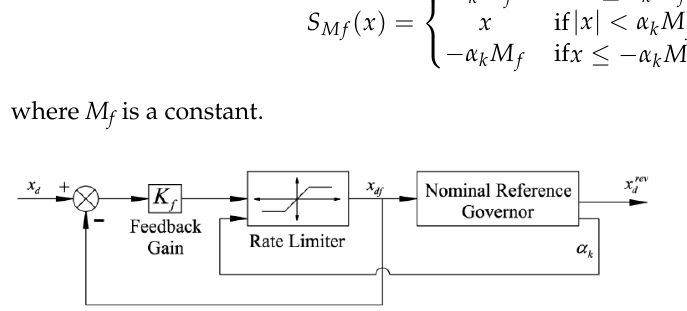
Table 1. Parameters of the electrohydraulic system. Parameter